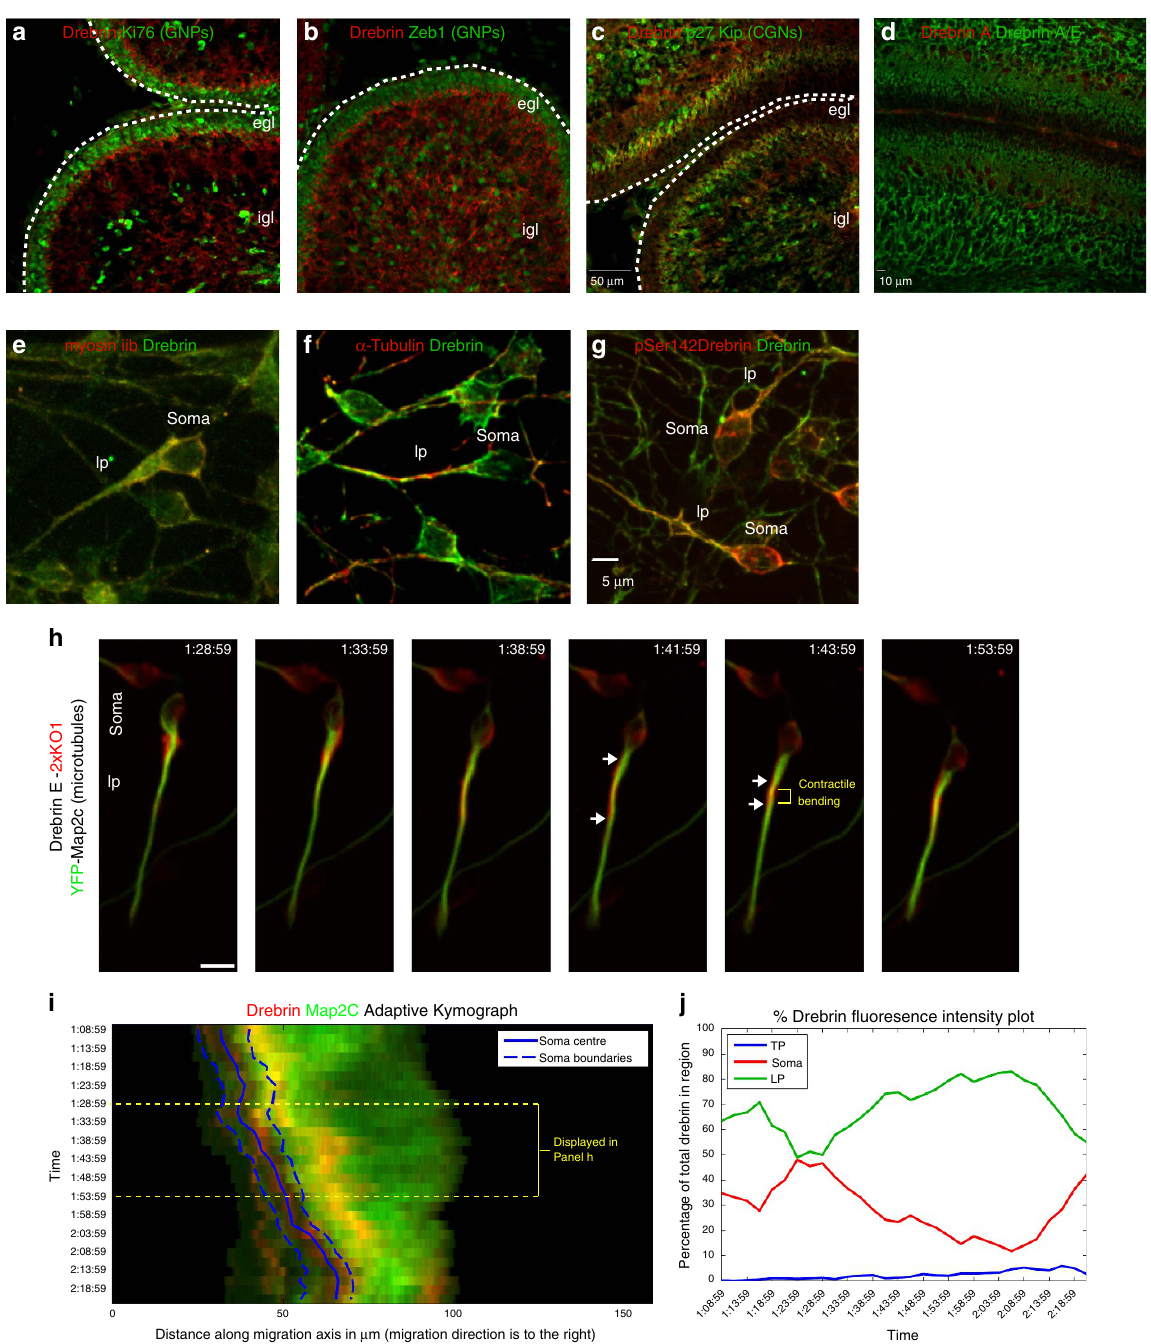
Figure 1 | Drebrin protein is expressed in differentiated CGNs and is dynamically localized to the leading process during two-stroke motility. ( a – c ) Immunohistochemical examination of drebrin expression in the P7 mouse cerebellum. In the P7 cerebellum, drebrin (red) is complementarily expressed with the GNP markers Ki67 (green) ( a ) or Zeb1 (green) ( b ) and is co-expressed in differentiated CGNs with p27Kip (green) ( c ), scale bar for each image equals 50 m m. Drebrin A expression (red) is minimal at P7 ( d ), scale bar, 10 m m. ( e – g ) Immunocytochemical examination of drebrin expression in CGNs grown in culture. Expression of drebrin protein (green) is coincident with myosin IIB, alpha-tubulin, and drebrin phospho-Ser142 immunoreactivity (all red) (lp ¼ leading process), scale bar for each equals 5 m m. ( h ) Drebrin (labelled with drebrin E 2x-KO1, red) is initially localized in the cell body but becomes restricted to the leading process f-actin domain, where it appears to contract around the time of somal translocation. Around the time of local contraction, bending is observed in the microtubule cytoskeleton (labelled by YFP-Map2C, white arrows). Scale bar, 10 m m. Time stamp ¼ hours:min:sec. ( i ) Adaptive volumetric kymographs of the sequences shown in h : the leading process and direction of migration is towards the right of the panel (dashed blue line ¼ somal boundaries; solid blue line ¼ soma centre; red ¼ drebrin E 2x-KO1; green ¼ YFP-Map2C). The yellow box highlights the time- lapse frames shown in h , in which a subpopulation of drebrin flows down the leading process in the direction of migration before the contraction of the leading process drebrin domain. Arrows indicate the borders of the drebrin domain as it contracts during a migration cycle. ( j ) Analysis of the percentage of regional drebrin localization signal in the soma and leading or trailing process in migrating neurons expressing drebrin E 2x-KO1, in which drebrin accumulates in the leading process in the active phase of migration. NATURE COMMUNICATIONS|8:14484|DOI: